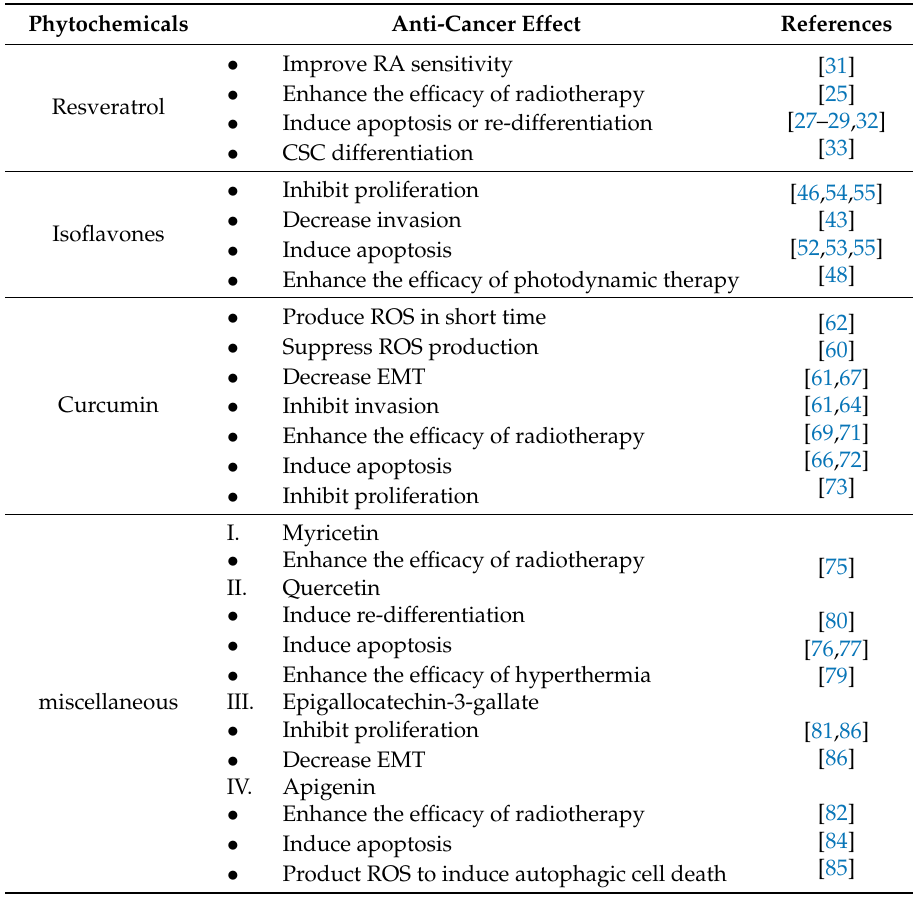
Table 1. Anti-thyroid cancer mechanisms of